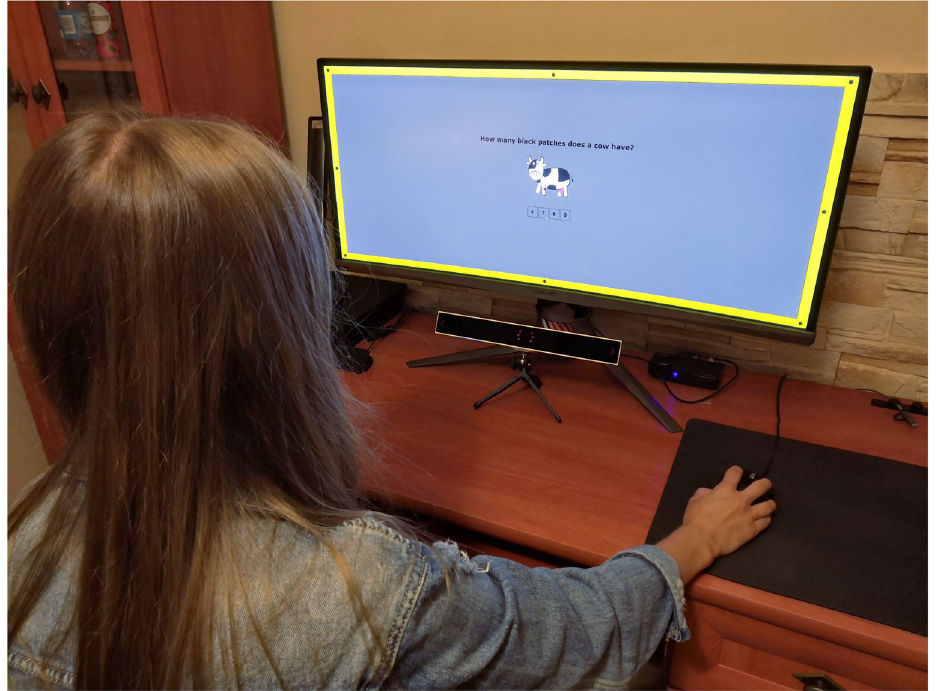
Figure 13. The course of the experiment and the experimental